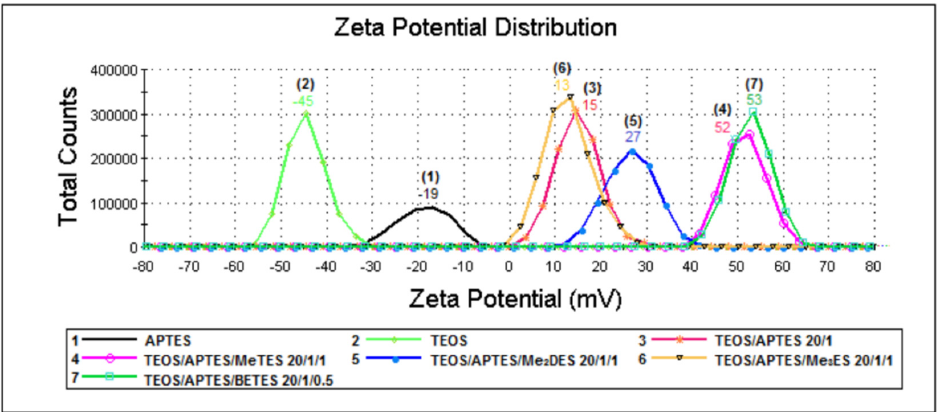
Figure 3. Zeta potential distribution of aminopropyl silica particles.